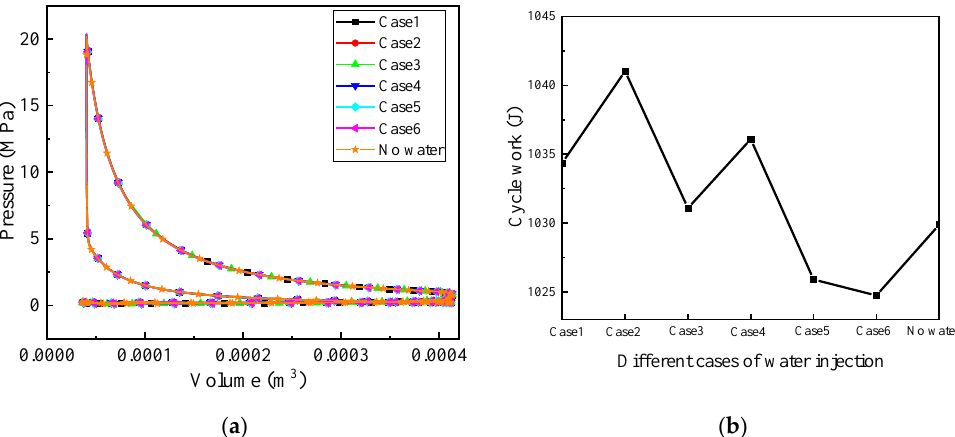
Figure 19. ( a ) P – V diagram and ( b ) cycle work in different water injection cases (CR = 10.3, ignition time = − 14 degCA).